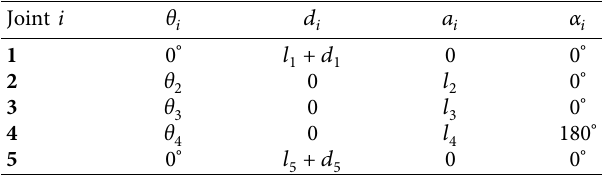
Figure 2: Scheme of the 5-DOF SCARA robot. Table 2: Parameters of